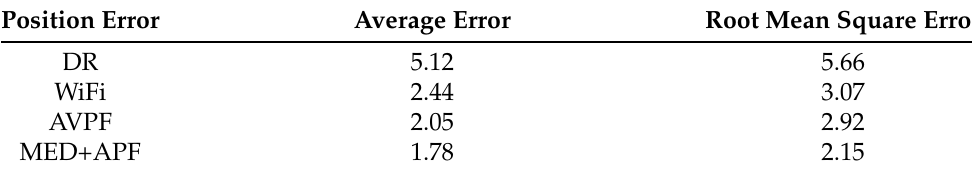
Table 5. Position errors of DR, WiFi, AVPF [32], and MED+APF